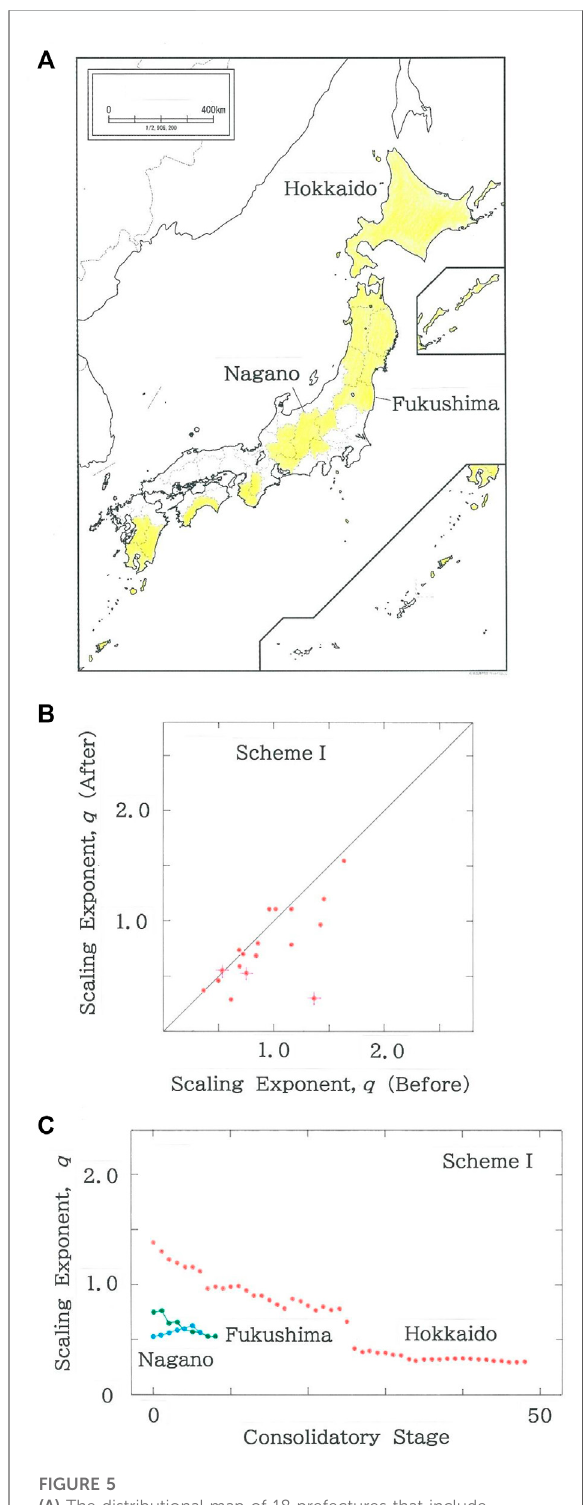
FIGURE 5 (A) The distributional map of 18 prefectures that include